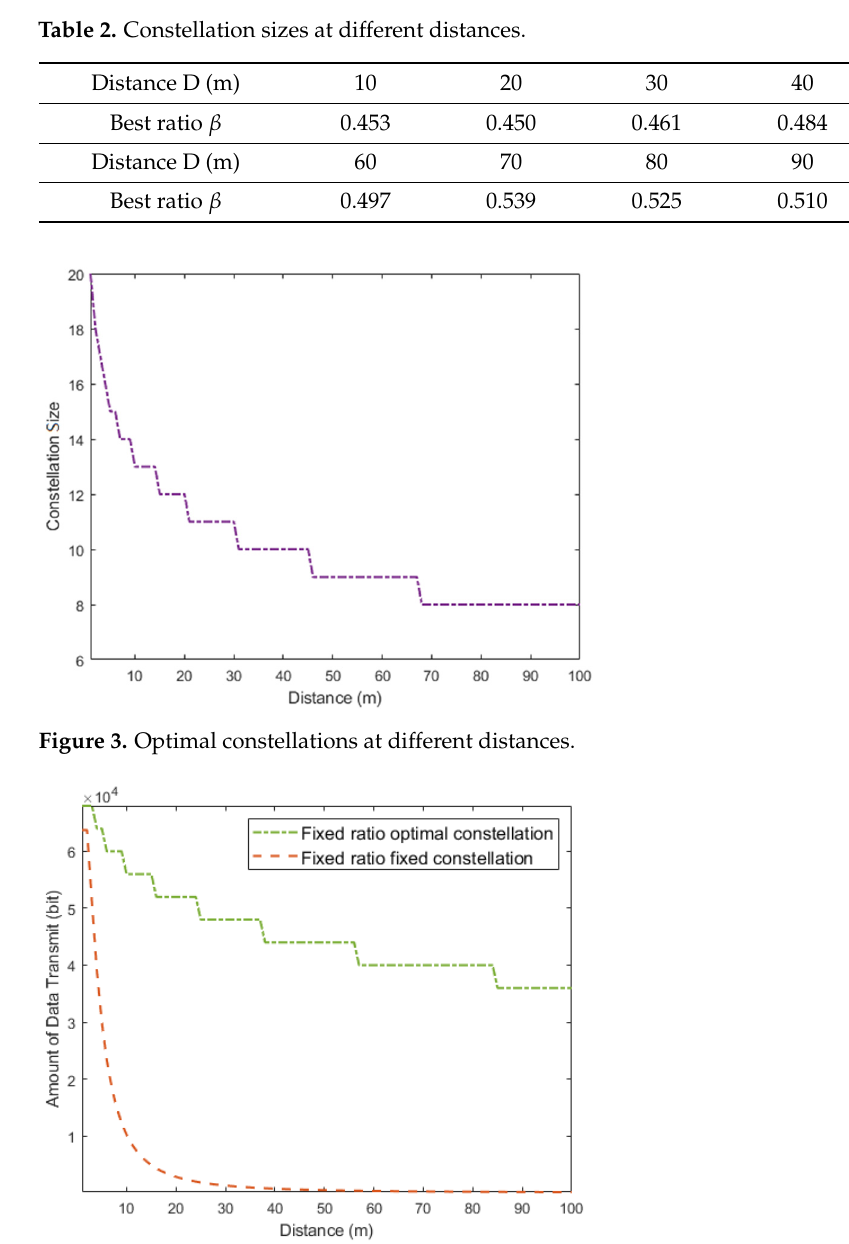
Figure 4. Fixed constellation versus optimized constellation size at a fixed time ratio.